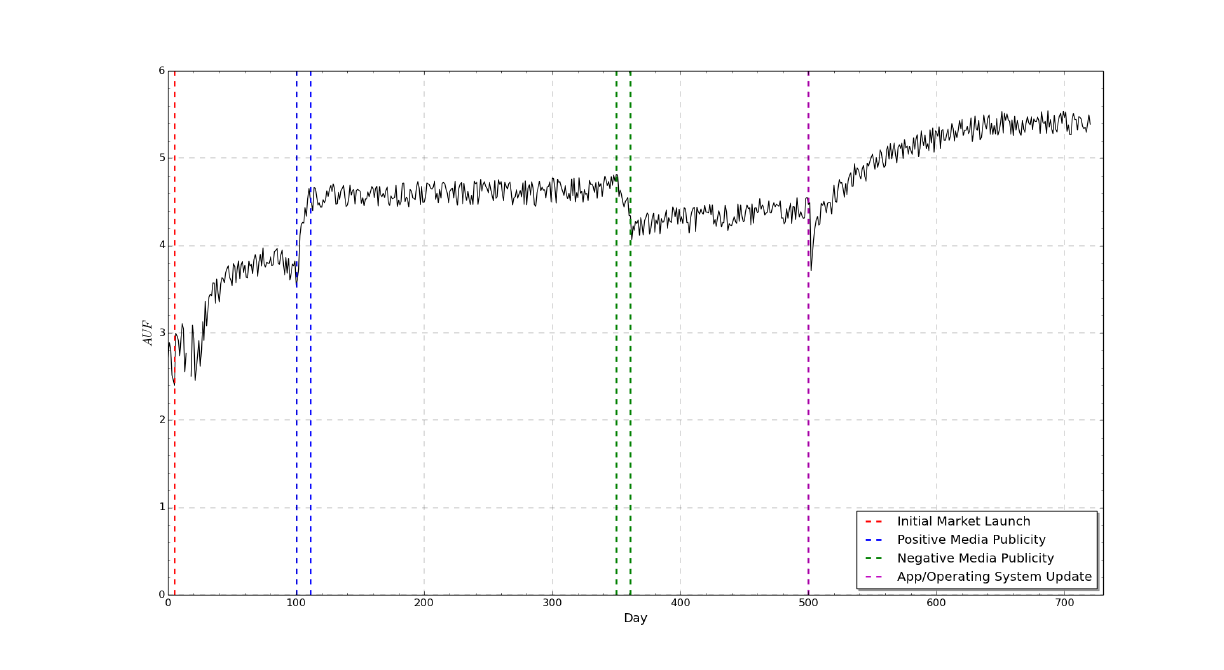
Figure 4. A graph showing app usage factor as a function of time for a single mobile app which is subject to a number of simulated app ecosystem